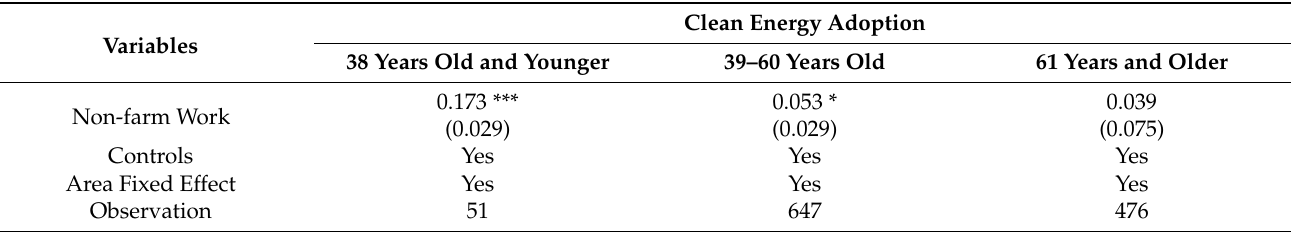
Table 6. Heterogeneity analysis: